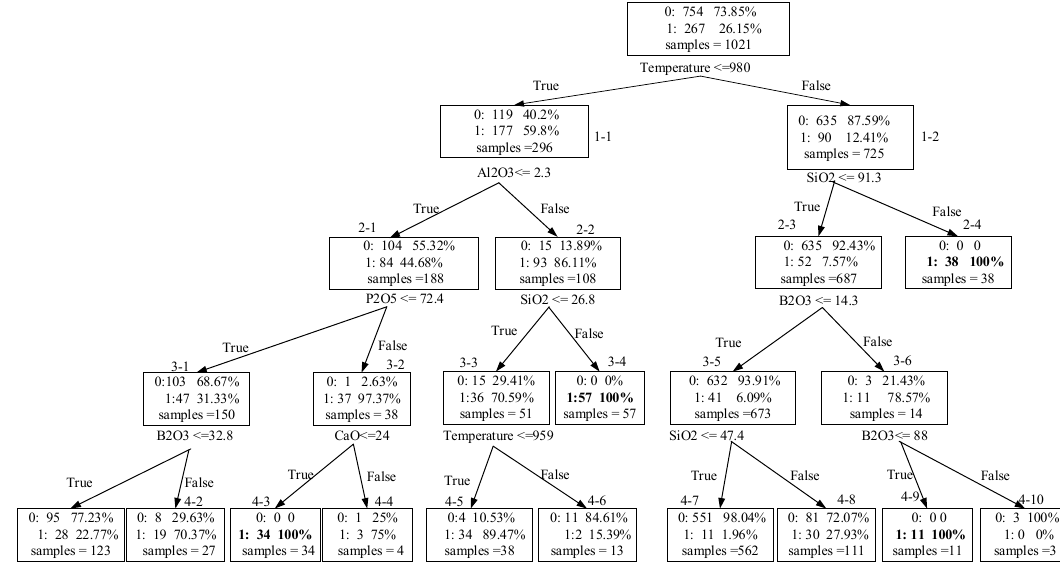
Figure 4. The surrogate results of the Gradient Boosting Decision Tree (GBDT) prediction in the first stage.